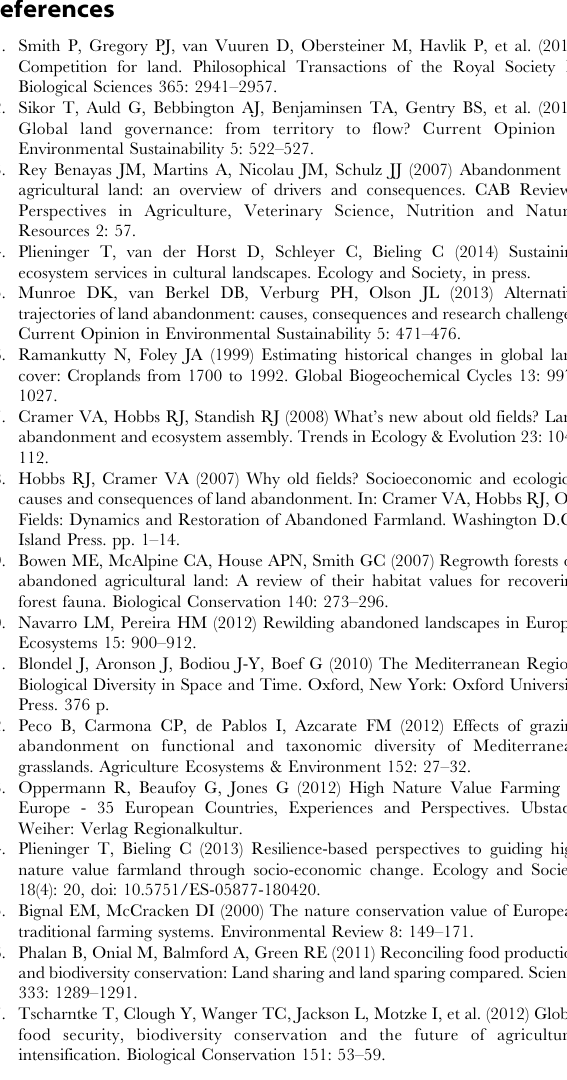
Figure S1 Flow diagram reporting the number of records identified, excluded, and added during the screening process. Table S1 PRISMA (Preferred Reporting Items for Systematic Reviews and Meta-Analyses) checklist. Table S2 Full references for the 51 studies included in the meta- analysis. Table S3 Cases included in the meta-analysis: Dependent variables. Table S4 Cases included in the meta-analysis: Independent variables.